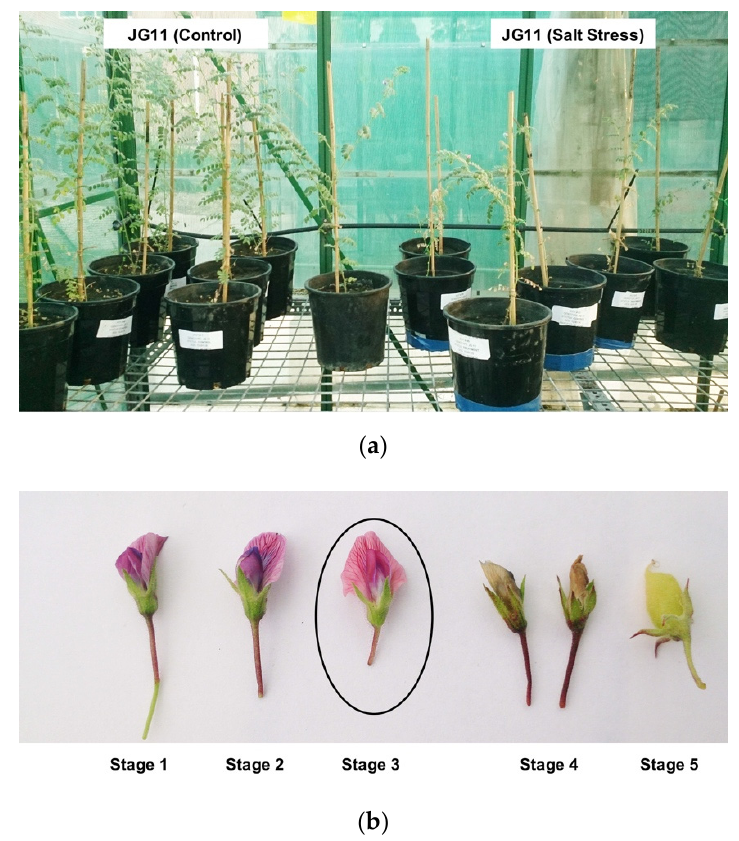
Figure 1. ( a ) Physiological responses of chickpea tolerant genotype (JG11) to salt stress in the glasshouse. A total of 80 mM NaCl was added and electrical conductivity (EC) was maintained at 1 dS/m as a measure of salinity throughout the experiment. The first flower was observed in JG11 after 34 days and ICCV2 after 30 days of sowing. As an effect of salt stress, plants show reduced plant height, slightly delayed flowering in the stressed tolerant plants, and fewer flowers in the sensitive genotype. ( b ) Flower developmental stages. Stage 3 fully opened flowers from both control and stress conditions were collected for transcriptomic